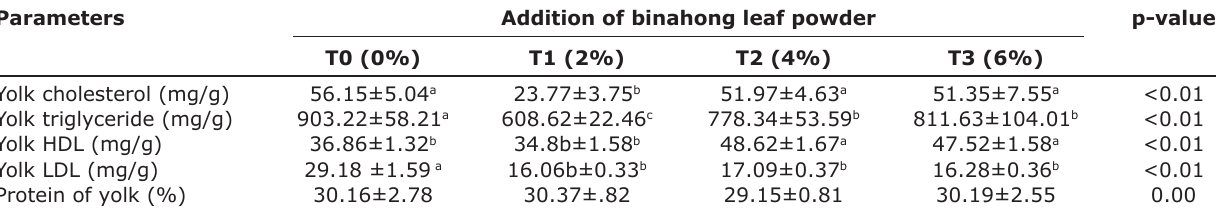
Table-5: Influence of the addition of binahong leaf powder on cholesterol, triglyceride, HDL, LDL, and protein of quail egg yolk.